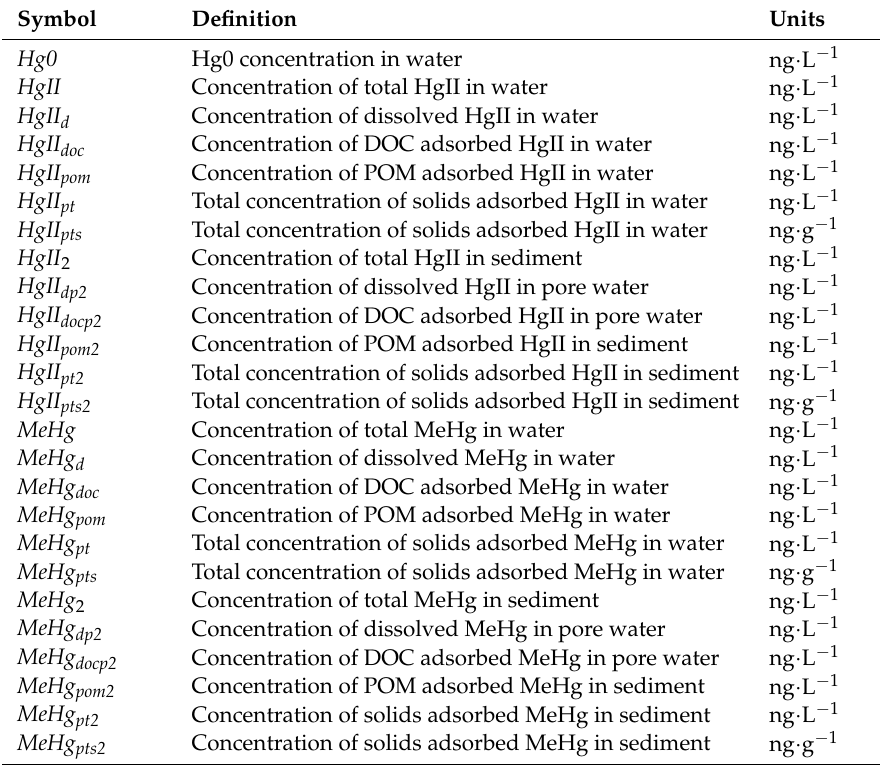
Figure 1. Conceptual representation of Hg speciation and processes modeled in the W2 model. Table 1. List of concentrations of Hg species computed in the W2 model.